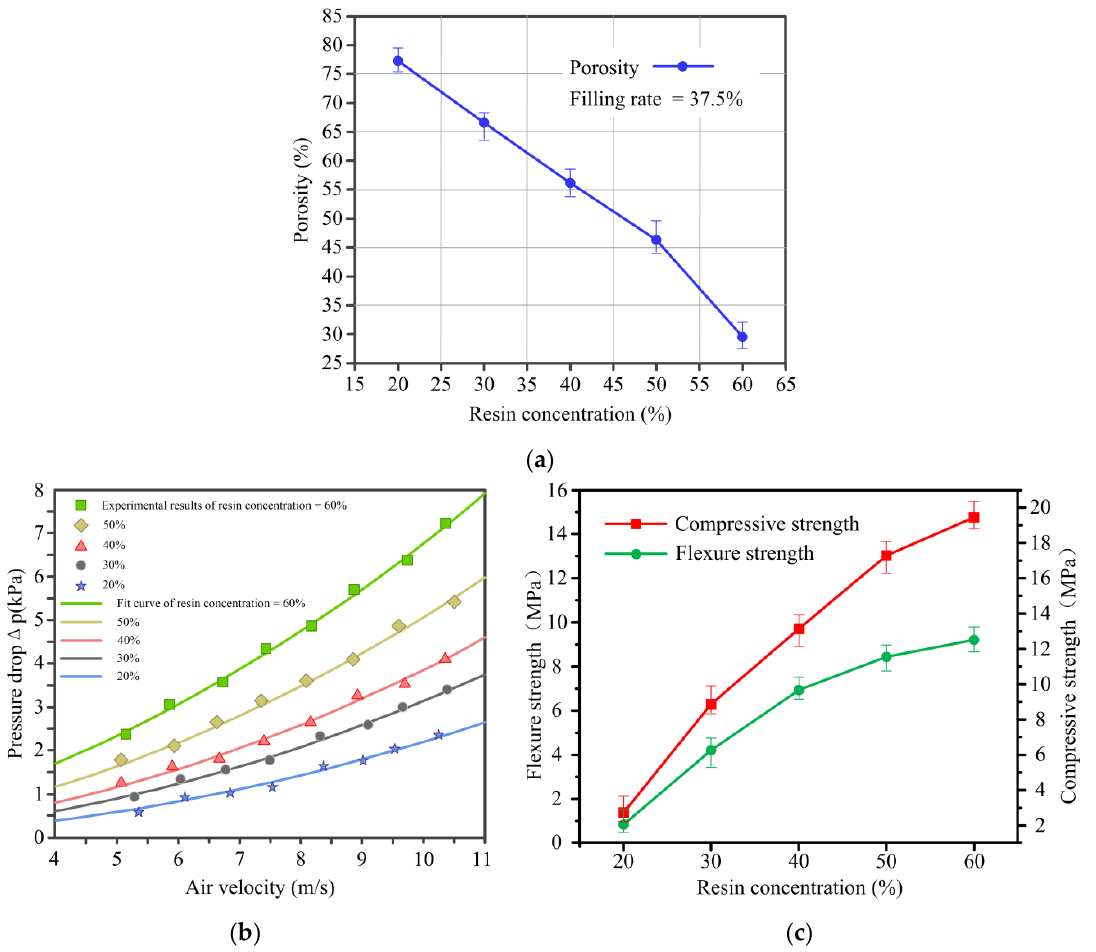
Figure 8. Experimental results of ( a ) porosity, ( b ) air permeability and ( c ) mechanical properties of C WCMs, with resin concentration of 20%, 30%, 40%, 50% and 60%, under a constant filling rate of wood powder of 37.5%. Table 1. Permeability constants and crystallite size of C WCMs sample with different resin con- centration under a constant filling rate of 37.5%.